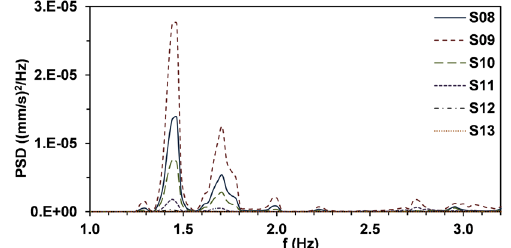
Figure 11. PSDs of S08-S13 in configuration C1.